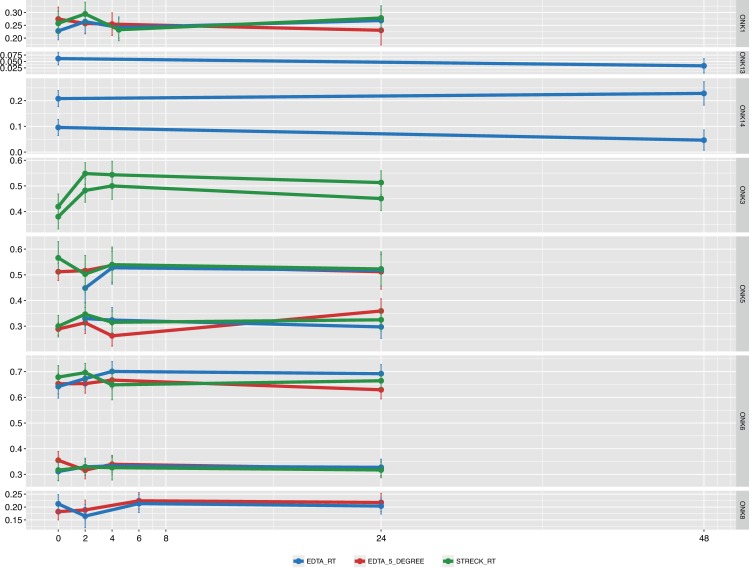
In vitro stability of ctDNA investigated by mutational profiling.Y-axis; the fraction of each mutation in the cfDNA. X-axis; the time points when plasma was harvested. The error bars display a 95% confidence interval of the estimated mutant allele fraction. Tube type and storage temperature—bottom legend. Patient ID—right panel label. Note, two informative mutations were identified for ONK3, ONK5, ONK6 and ONK14.